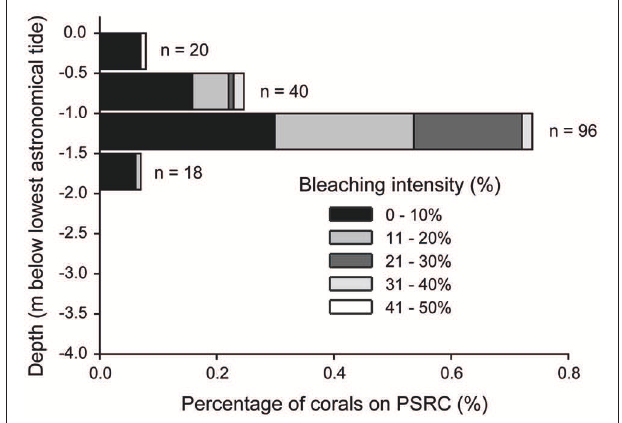
FIGURE 6 | Incidences of coral bleaching with depth (0.5m depth intervals below lowest astronomical tide) at Paluma Shoals reef complex in August 2016. Bleaching intensity of corals (% of total colony surface) is also shown within each depth category.